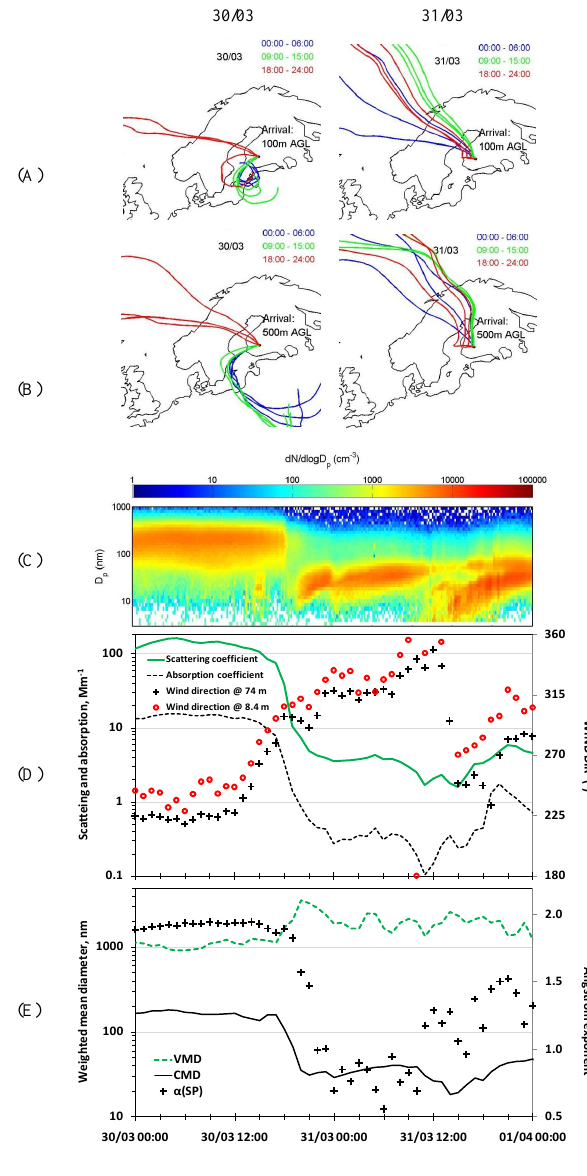
Fig. 15. Aerosol optical properties, size distributions, and air mass transport routes on 30–31 March 2007, the time is UTC +2h. (A) : HYSPLIT 4 backtrajectories arriving at SMEAR II 100ma.g.l.; (B) : Backtrajectories arriving at 500ma.g.l.; (C) : Particle num- ber size distributions; (D) : σ SP , σ AP , and wind direction at two altitudes; (E) Volume mean diameter, count mean diameter, and ˚Angstr¨om exponent of